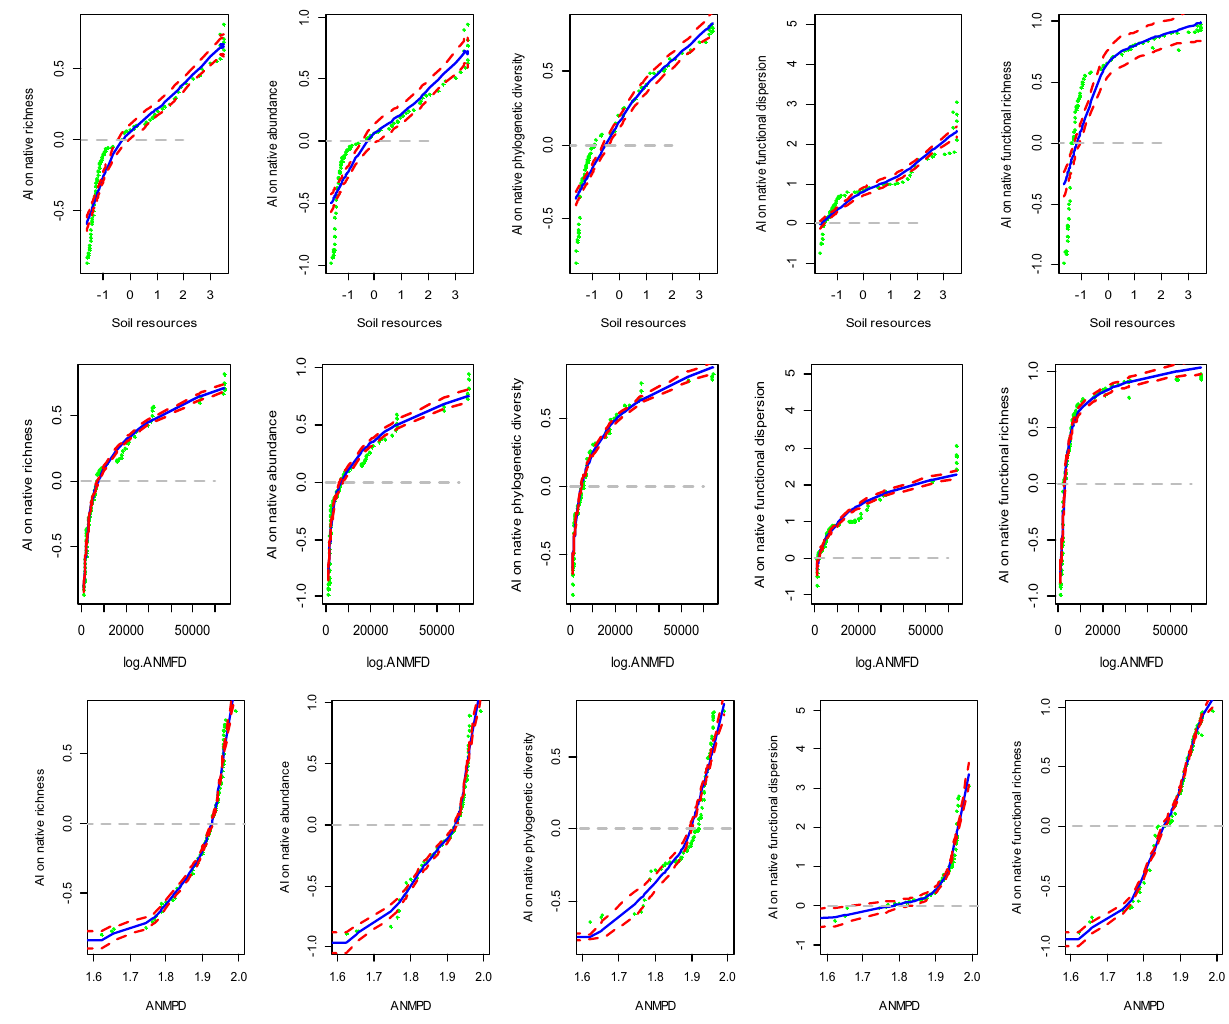
Figure 3. Alien impact (AI) on native richness, abundance, PD, FDis, FRic, in responding to soil resource availability (nitrogen, organic matter, soil moisture summarized in composite variable with a PCA) and the alien relatedness (functional and phylogenetic) to natives in SKP. Blue solid lines represent the average response expected by GAM model with 95% confidence intervals (red dashed lines). Green points represent the observed data